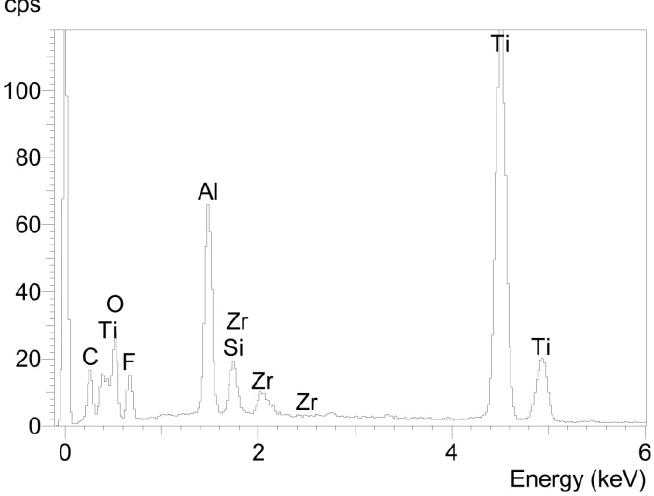
Figure 5. SEM images of the fractured surface of 5_Ti_Ti at magnifications of ×50 ( a ) and ×1000 ( b ).